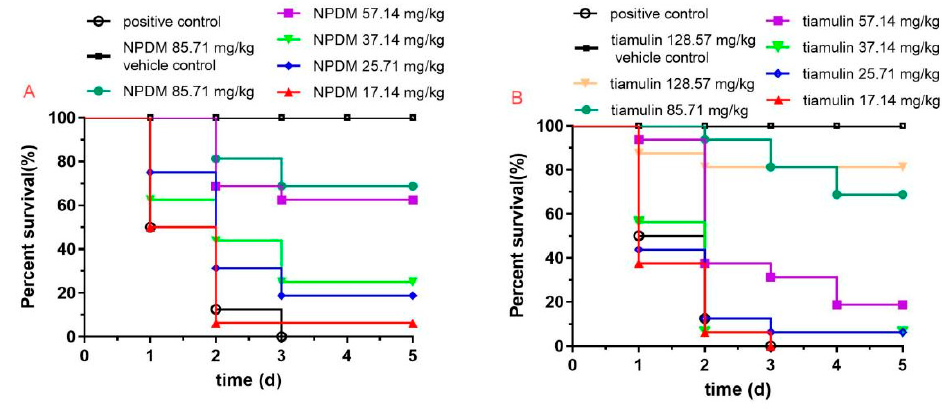
Figure 7. Survival of G. mellonella challenged with MRSA ATCC 43300 after treatment with different doses of NPDM ( A ) or tiamulin ( B ).